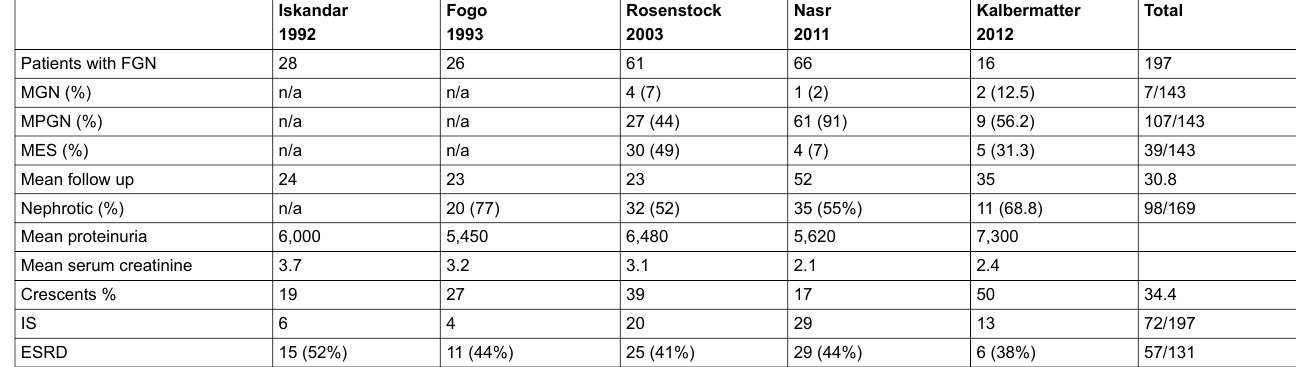
Table 4: Summary of all studies concerning fibrillary Glomerulonephritis with more than 10 patients and clinical outcome data [7, 8, 11, 17]. Iskandar